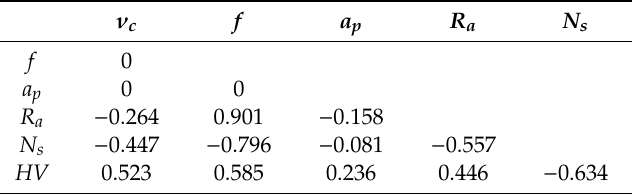
Table 5. Correlation between factors and responses.